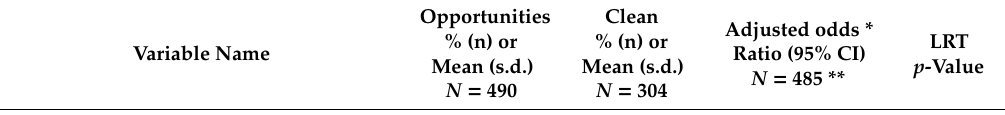
Table 4. Descriptive characteristics of the sample, and adjusted odds ratio (Model 2) for the association between each modifiable determinant and avoiding glove